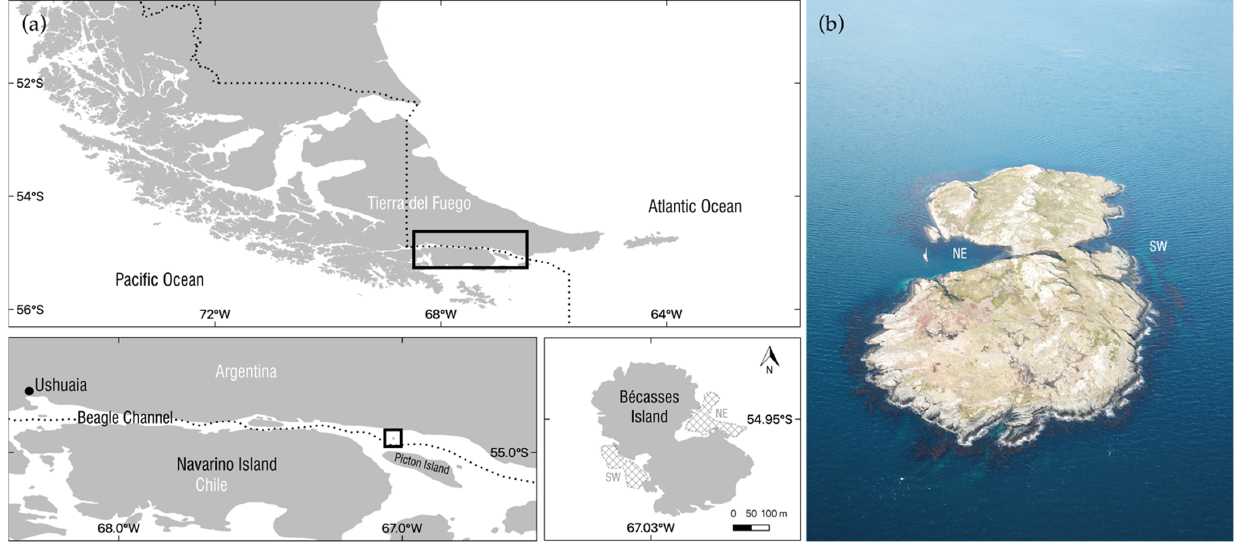
Figure 1. Bécasses Island location in the Beagle Channel, Tierra del Fuego, Argentina. ( a ) A map of the study area, the surveyed zones are indicated with grid lines (SW = Southwest and NE = North ‐ east). ( b ) Bécasses Island, photo acquired by a drone, survey zones marked with letters (SW and NE); and the sailboat “Kostat” is observed in the NE bay.